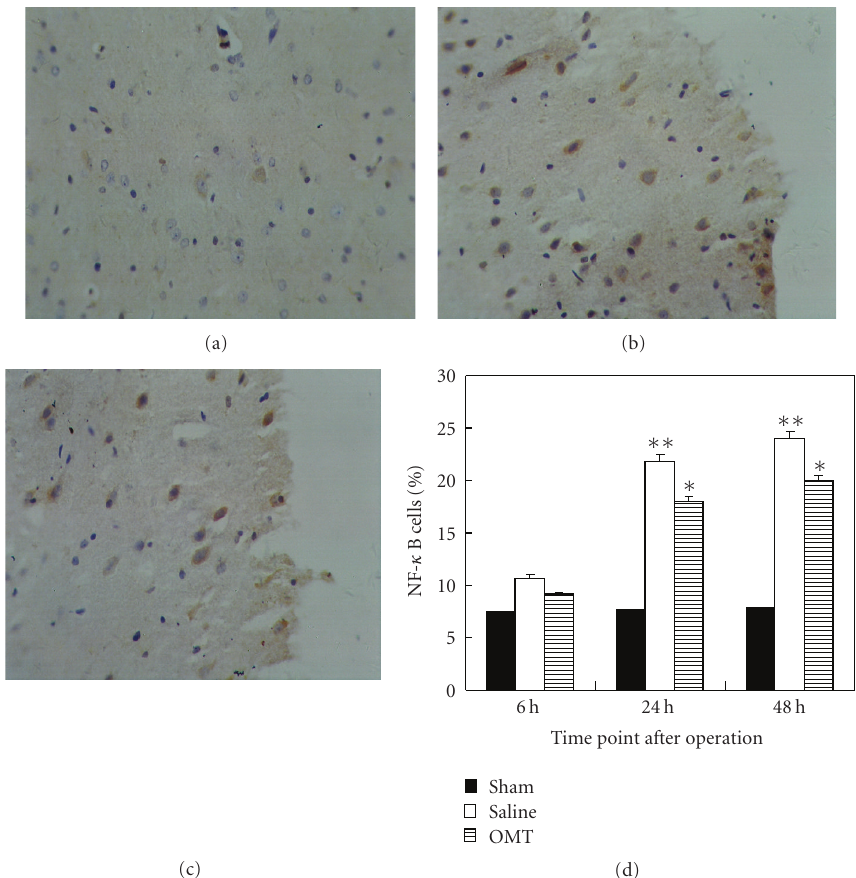
Figure 6: NF- κ B expression detected by immunohistochemistry. (a) NF- κ B expression in the sham group: NF- κ B expression could be observed periodically in the sham group at 24 hours. (b) NF- κ B expression in the saline group: NF- κ B expression evidently increased in the saline group at 24 hours. Positive cells were defined as haning bu ff y grains in the cellular nucleus and cytoplasm. (c) NF- κ B expression in the OMT treatment group: NF- κ B expression decreased relatively in the OMT treatment group at 24 hours. (d) NF- κ B expression in each group at all time points: there was no di ff erence among all test groups at 6 hours. It was evidently higher in the saline group at 24 hours and lasted up to 48 hours. Compared with the saline group at identical time points, NF- κ B expression was lower in the OMT treatment group, and the di ff erence was significant ∗∗ P < . 01 and ∗ P < . 05 compared with